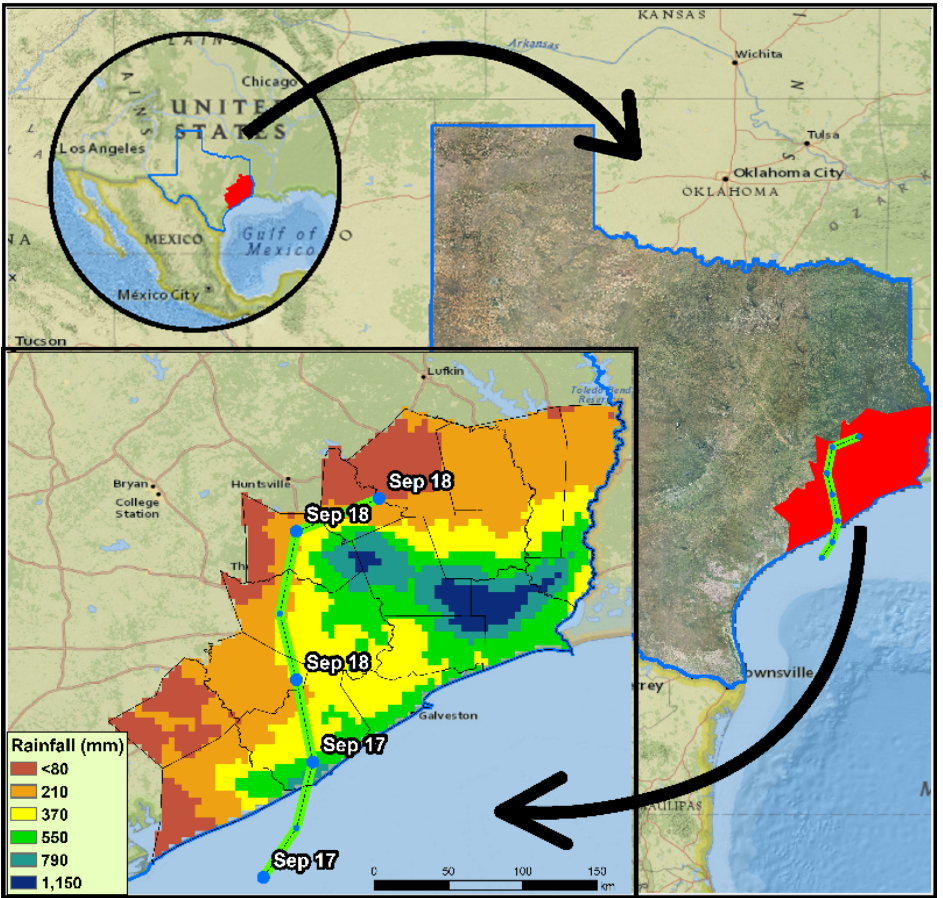
Figure 1. Path track of the Tropical Storm Imelda before and after its landfall in Freeport, TX at 17:45–18:00 UTC 17 September 2019 (green line shows the path of the Tropical Strom Imelda). Precipitation estimates are based on radar data.